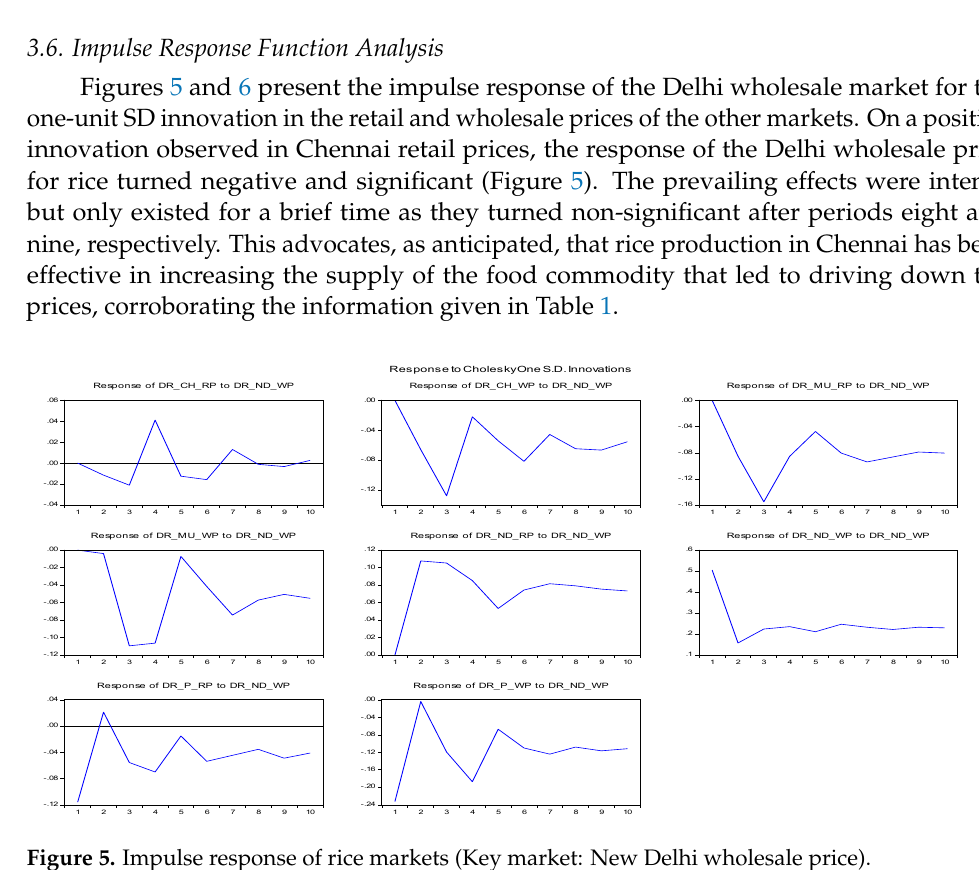
Figure 5. Impulse response of rice markets (Key market: New Delhi wholesale price).